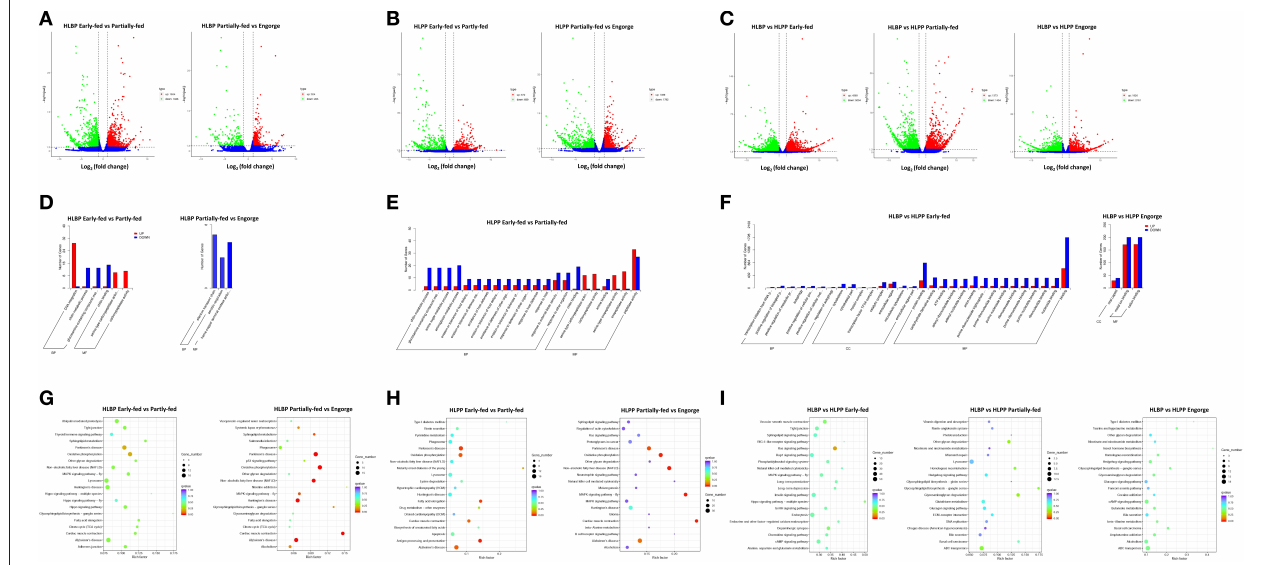
FIGURE 1 | Functional clusterization of differentially expressed genes (DGEs) in the ovary of two reproductive groups of H. longicornis . The volcano plots show the fold change in gene expression by the x-axis (log 2 ) and the statistical significance of differences by the y-axis (-log 10 ). Up regulated and down regulated genes spots are highlighted in green and red circles, respectively. (A) Comparison of the H. longicornis bisexual population (HLBP) in different feeding stages. (B) Comparison of HLPP in different feeding stages. (C) Comparison of different reproductive groups. The Gene Ontology (GO) annotation enrichment of differentially expressed genes (DEGs). The histogram shows the up-regulated and down-regulated different categories in red and blue, respectively. (D) Comparison of bisexual H. longicornis (HLBP) in different feeding stages. (E) Comparison of parthenogenetic H. longicornis (HLPP) in different feeding stages. (F) Comparison of the different reproductive groups. The Kyoto Encyclopedia of Genes and Genomes (KEGG) pathway analysis of differentially expressed genes (DEGs). The colors indicate saliency and size indicates the number of genes in the pathway. (G) Comparison of bisexual H. longicornis (HLBP) in different feeding stages. (H) Comparison of parthenogenetic H. longicornis (HLPP) in different feeding stages. (I) Comparison of the different reproductive